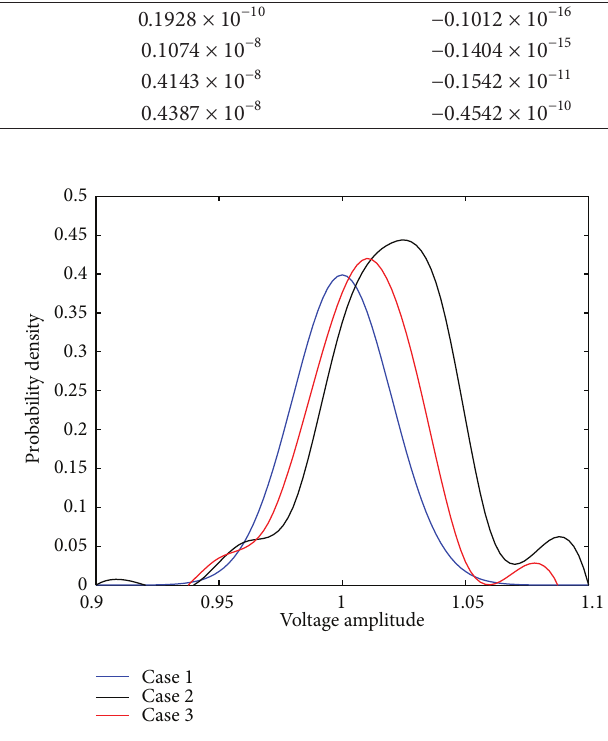
Figure 4: Voltage probability density function of the 33rd